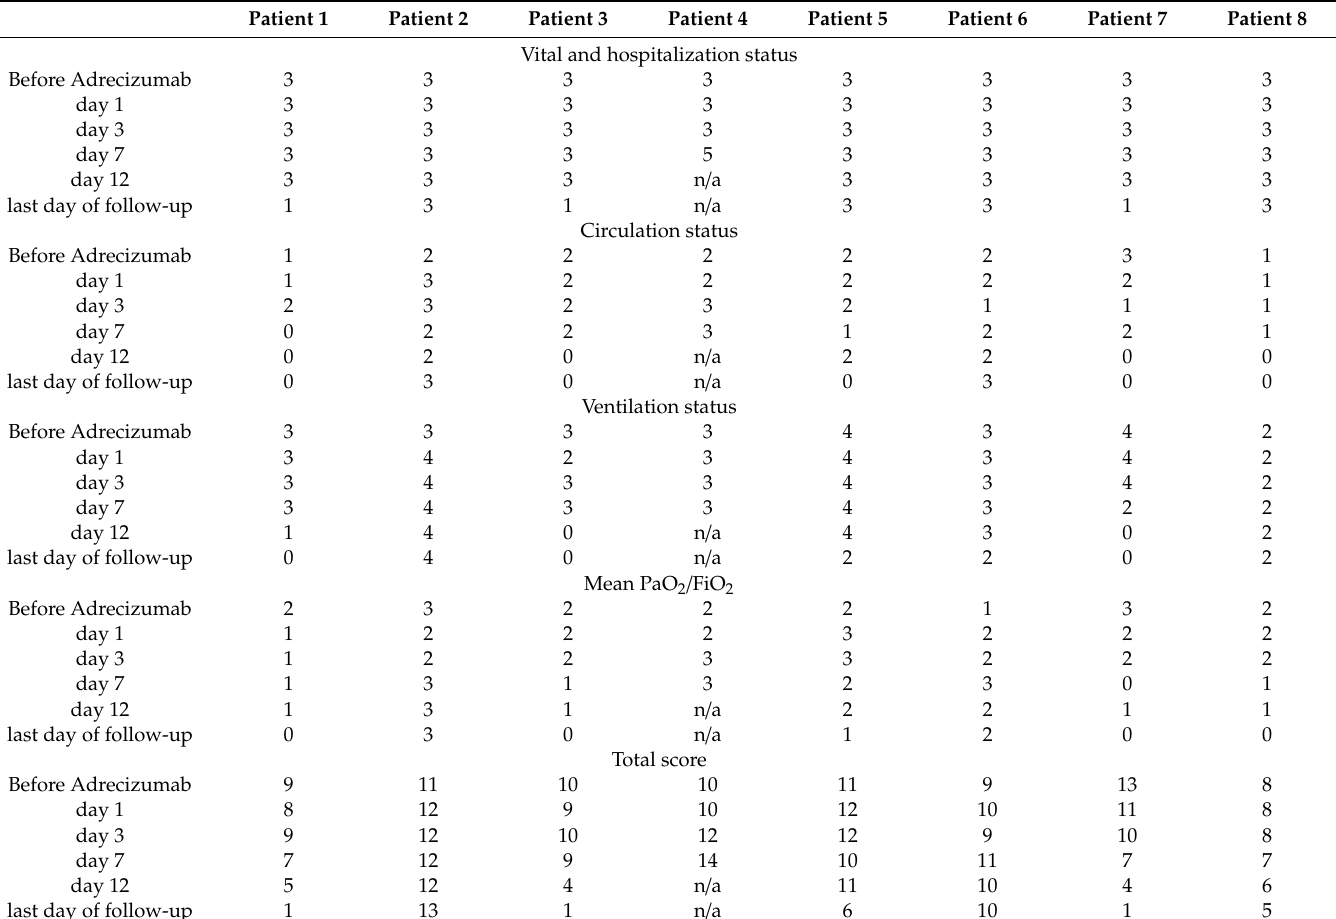
Table 4. Comparison of the disease severity score before and after the Adrecizumab